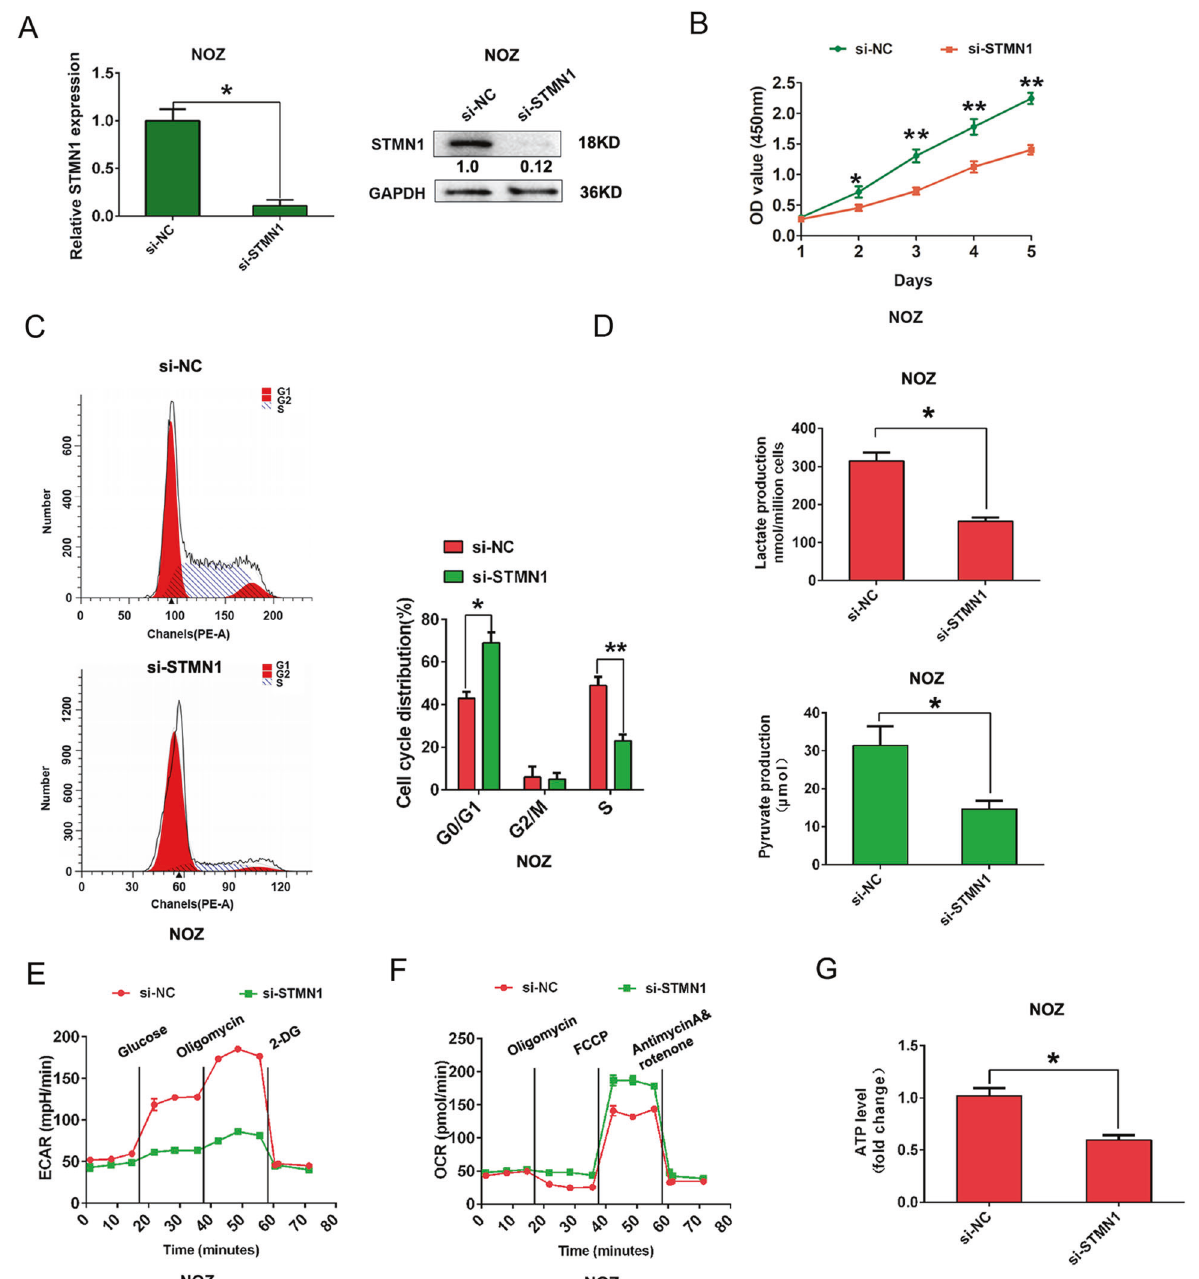
Fig. 7 STMN1 affects cell proliferation and cell glycolysis in GBC cells. A The mRNA or protein expression of STMN1 was shown after NOZ cell was transfected with si-NC or si-STMN1. B The cell viability was detected by CCK8 assays in NOZ cells after cells were transfected with si- NC or si-STMN1. C Flow cytometry analysis was shown as the percentage cell phase distribution including G0/G1, S, and G2/M phases after transfection of NOZ cells with si-NC or si-STMN1. D The lactate production or pyruvate production levels were analyzed after transfection of NOZ cells with si-NC or si-STMN1. E , F The ECAR or OCR analysis for mitochondrial respiratory capacity was conducted using a Seahorse XFp assay after transfection of NOZ cells with si-NC or si-STMN1. G ATP quantity analysis revealed the ATP quantity after transfection of NOZ cells with si-NC or si-STMN1. * P < 0.05. ** P <